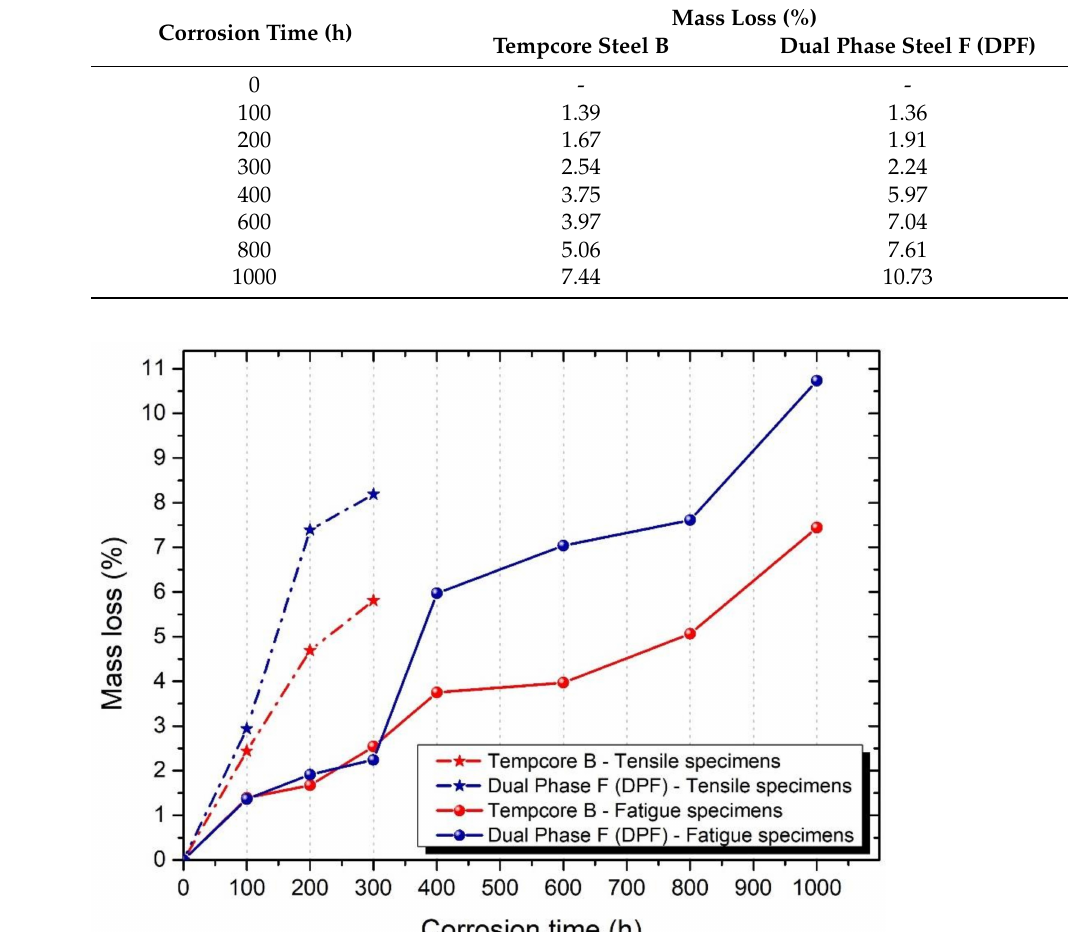
Figure 10. Mass loss vs. corrosion